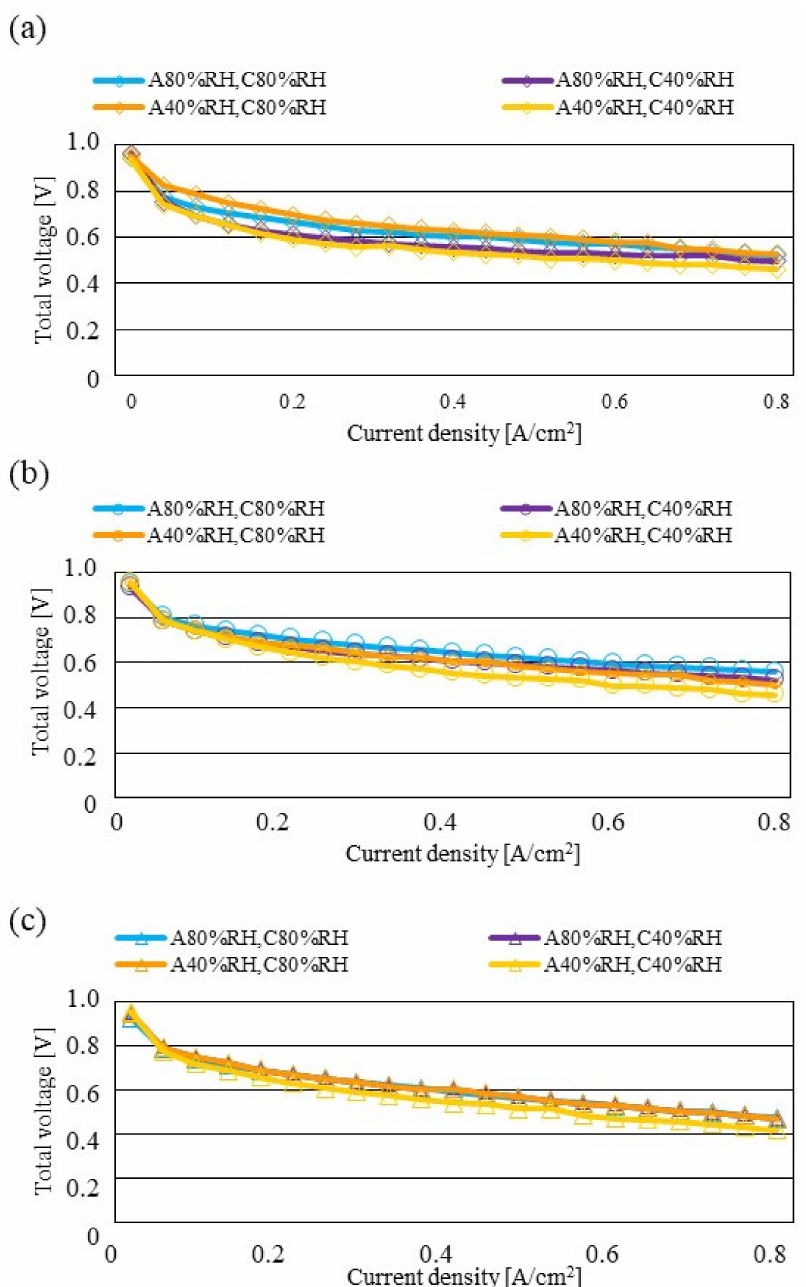
Figure 10. Comparison of polarization curves, among different RHs using the separator thickness of 2.0 mm: ( a ) the initial operation temperature = 80 ◦ C, ( b ) the initial operation temperature = 90 ◦ C, ( c ) the initial operation temperature = 100 ◦